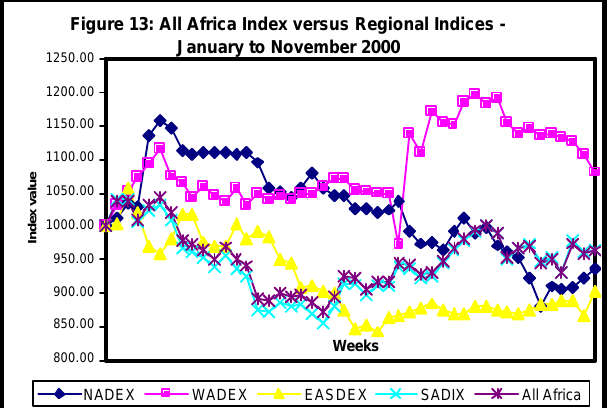
Figure 13: All Africa Index versus Regional Indices - January to November